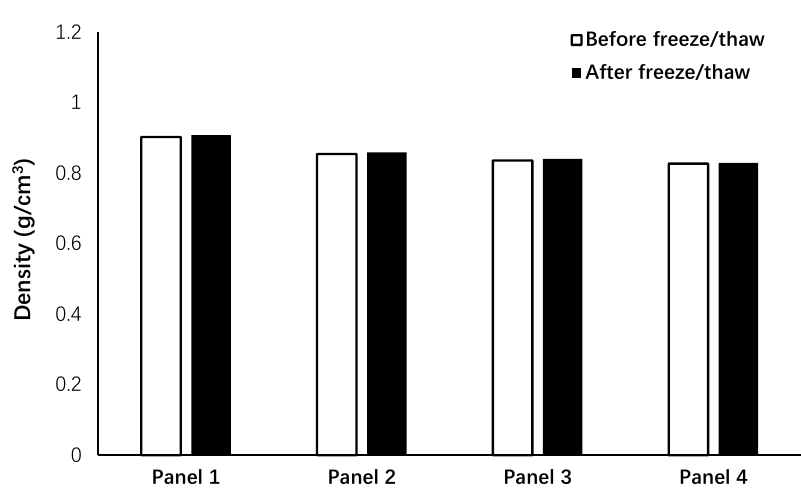
Materials 2018 , 11 , x FOR PEER REVIEW Figure 7. Effects of carbonation on the density of the panels. Figure 7. Effects of carbonation on the density of the panels.